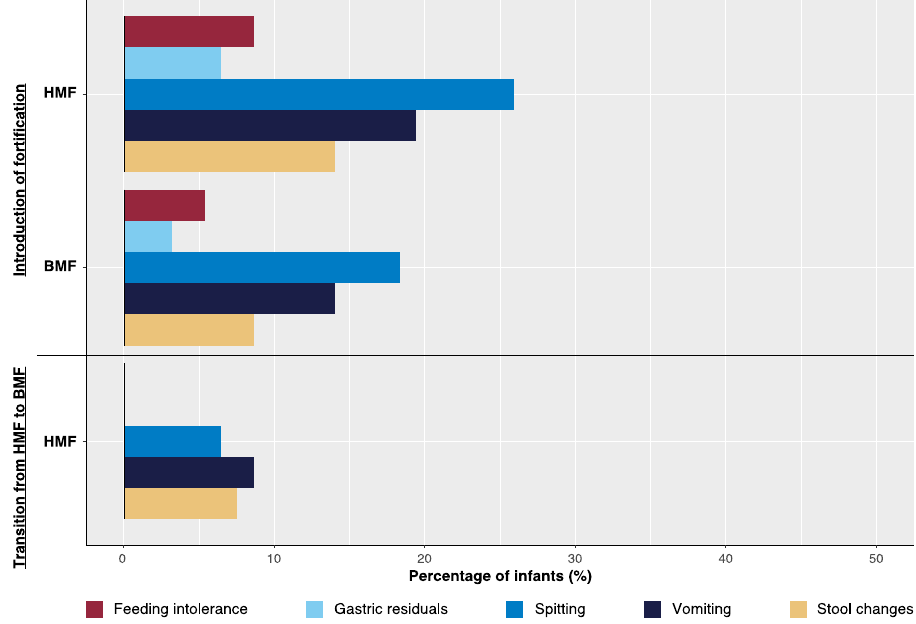
Figure 3. Di ff erences in gastrointestinal tolerance during fortifier introduction and fortifier transition between groups. Table 5. Feeding tolerance at fortifier introduction: comparison of data from the present study with the literature.